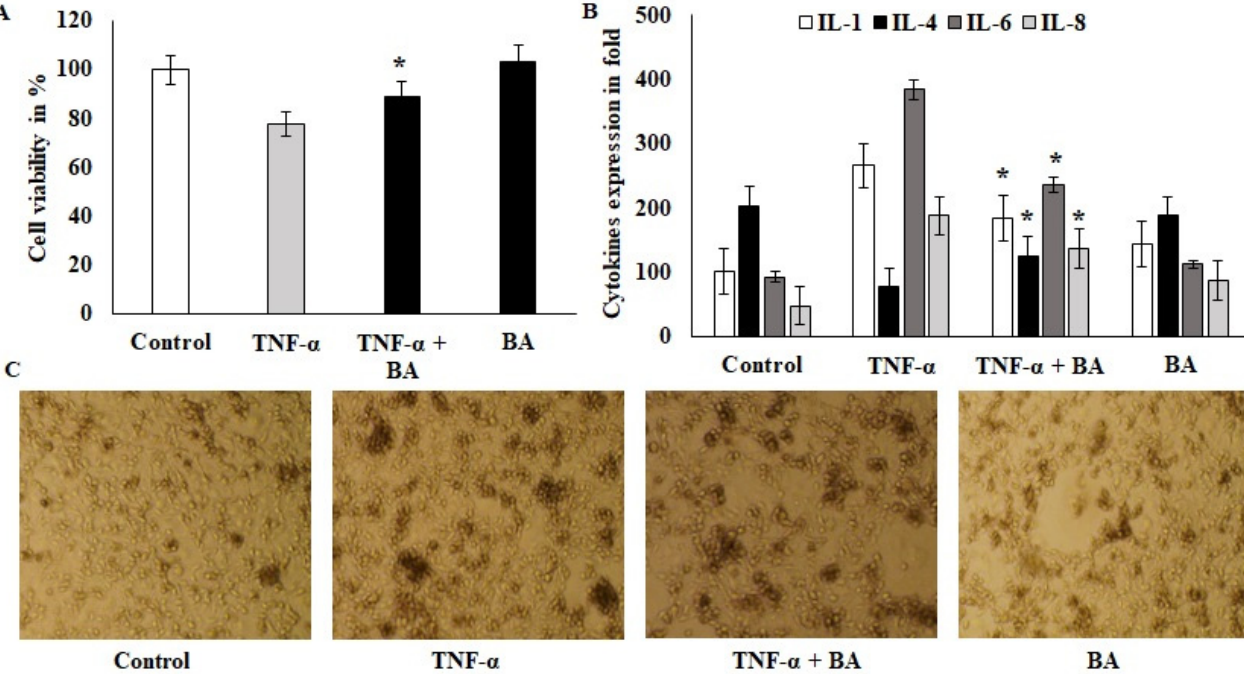
Figure 1. Effect of probiotics on colon cells: ( A ) BA 10 8 microbial loads treated with ht29 colon cells and incubated for 2 h; after incubation, the 6-well plates were aspirated with ampicillin 20 U/mL, and the treated cells were quantified for cell viability using 4% trypan blue. ( B ) TNF- α -induced HT29 cells were treated with BA for 12 h and the cell-free supernatant was collected and used for cytokine IL1, IL4, IL6 and IL8 estimation and the values were expressed as pg/mL. All of the data were collected from three individual experiments and pooled and expressed as mean ± SD ( p < 0.05). ( C ) Phase-contrast images of TNF- α -induced HT29 cells that were treated with BA for 2 h; the magnification in the microscopic image was 200 × . * p < 0.05 represents significance compared to the TNF α vs. TNF α + BA group.